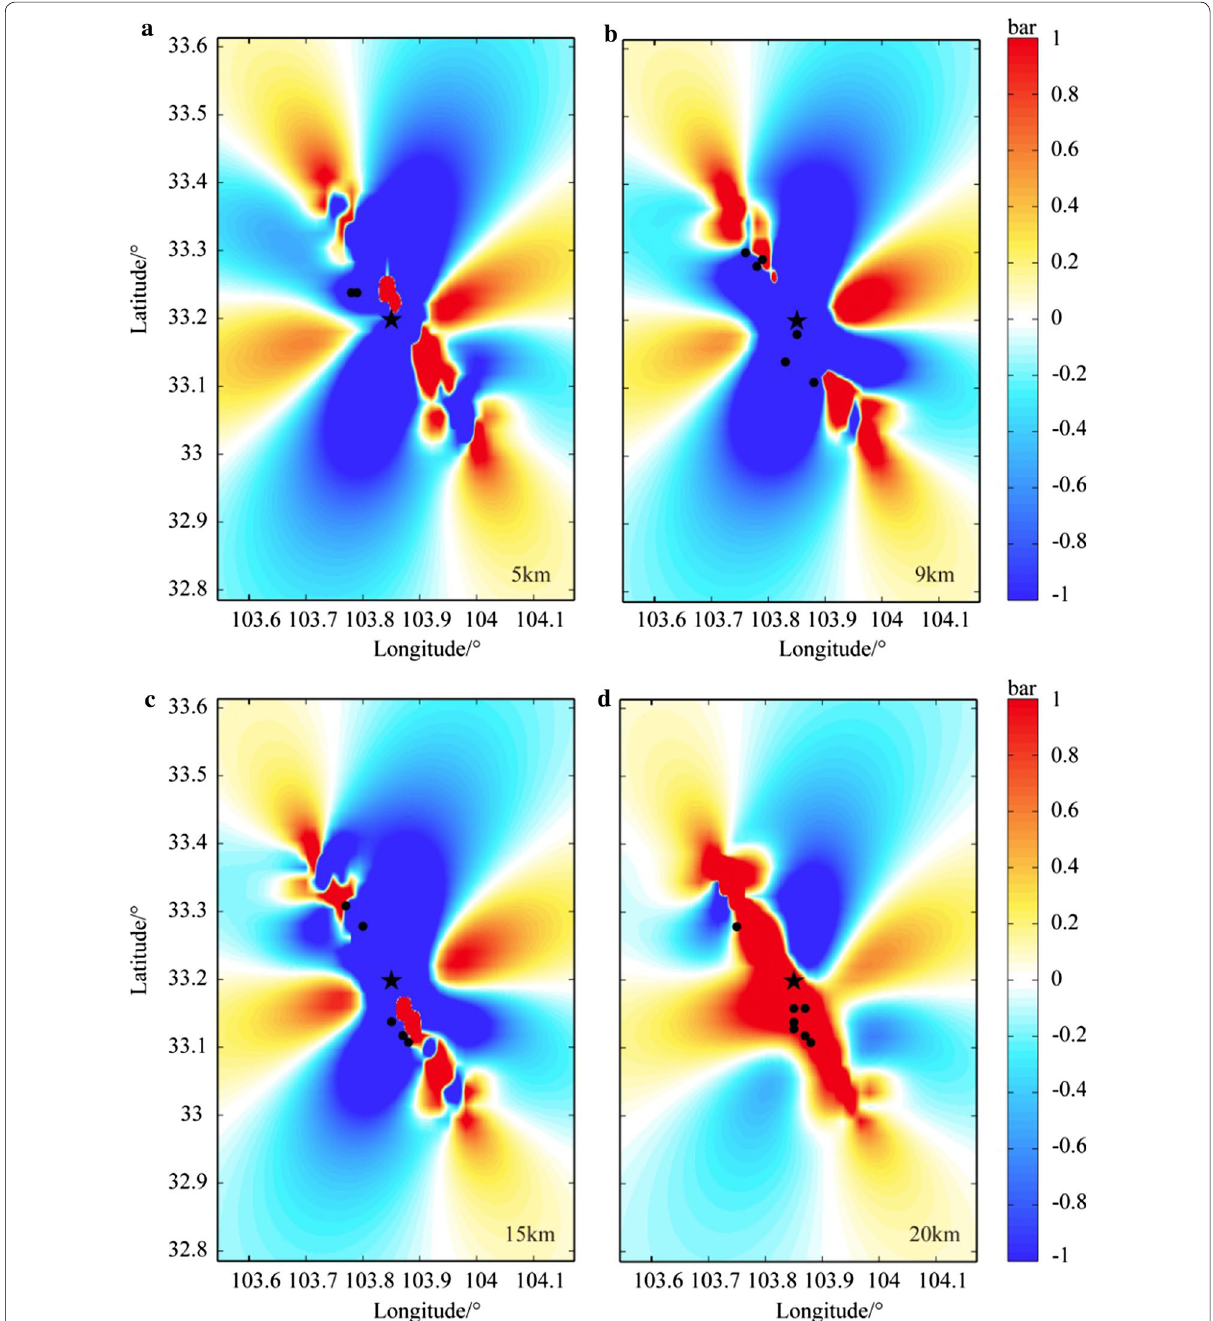
Fig. 4 Stress changes imparted by the 2017 Jiuzhaigou earthquake at different depths with an effective friction coefficient of 0.4. a 5 km, b 9 km, c 15 km and d 20 km. The black circles represent M L 3 aftershocks in 1 day after main-shock and their depths are limited between the calculated ≥ depths of 3 ±